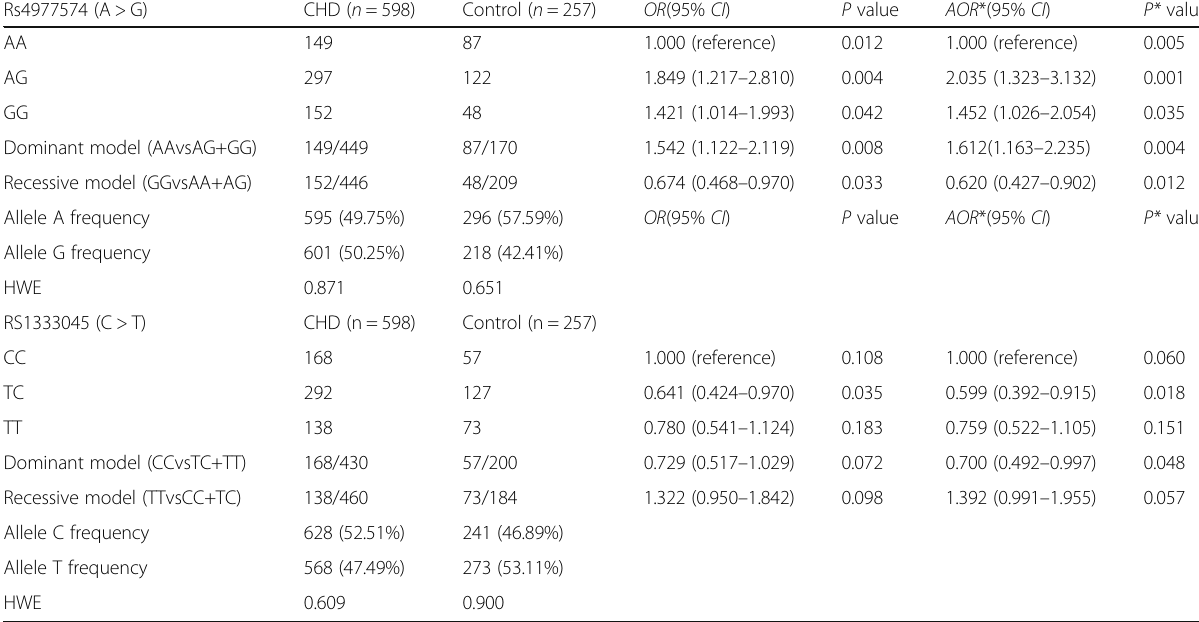
Table 6 Logistic analysis of the association between SNPs rs4977574 and rs1333045 and CHD risk Rs4977574 (A > G)